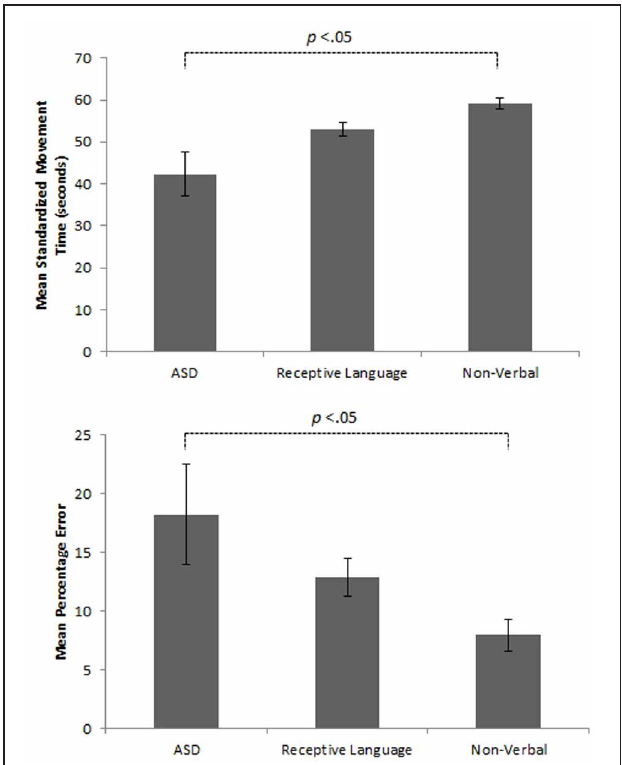
FIGURE 2 | Example summary graphs showing mean level of overall percentage error and associated standardized times (seconds) for the three different experimental